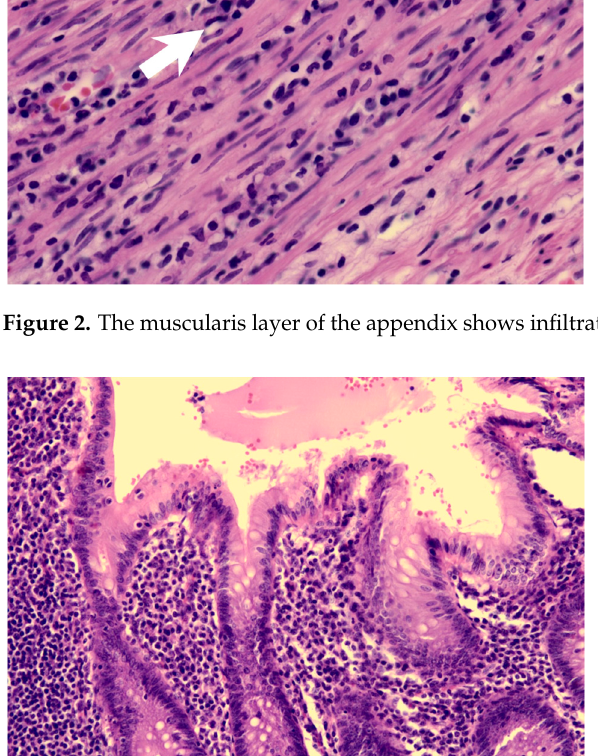
Figure 3. The mucosa of the appendix was intact, without erosion or ulceration.